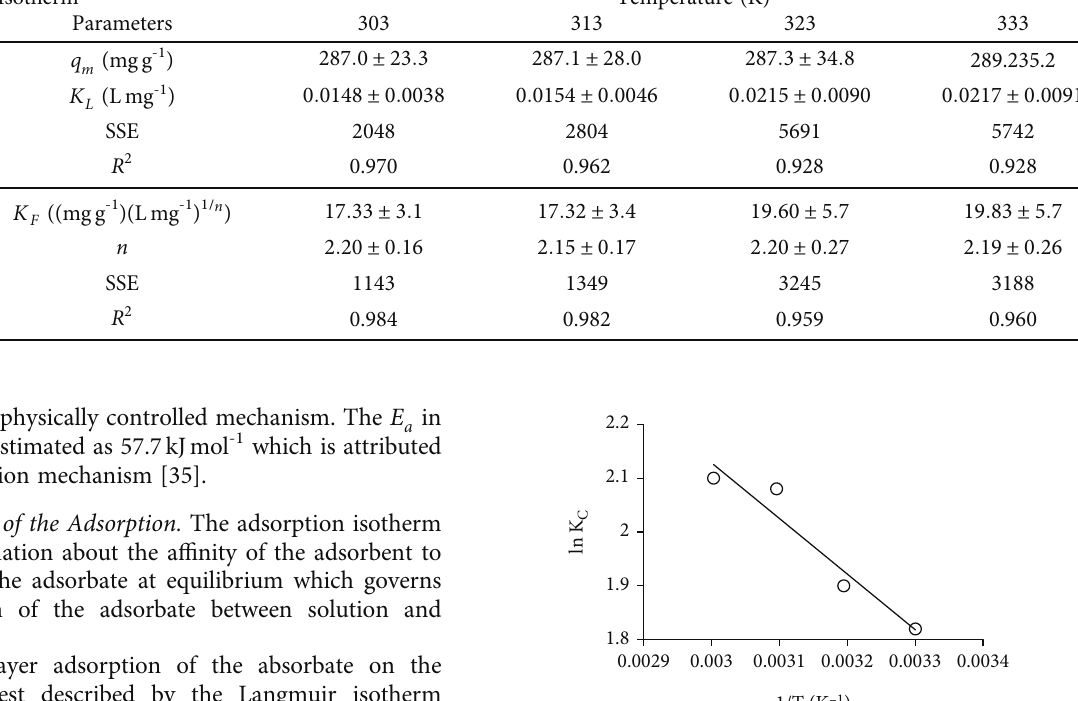
Table 3: The adsorption isotherm parameters for the adsorption of BF onto GC. Isotherm